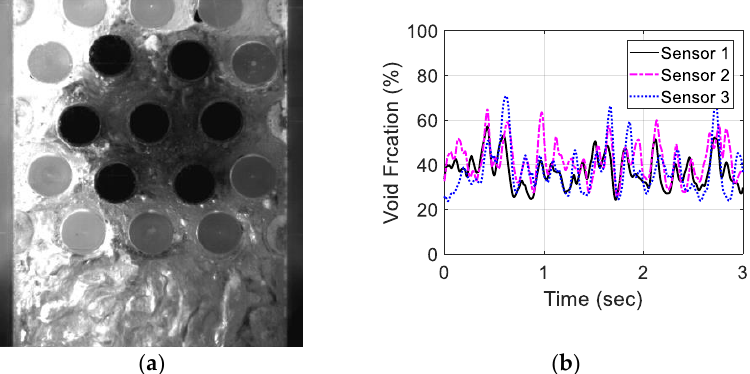
Figure 26. Experimental results for an air flow rate of 40 L/min for the three-sensor configuration: ( a ) flow visualization and ( b ) void fraction signal.